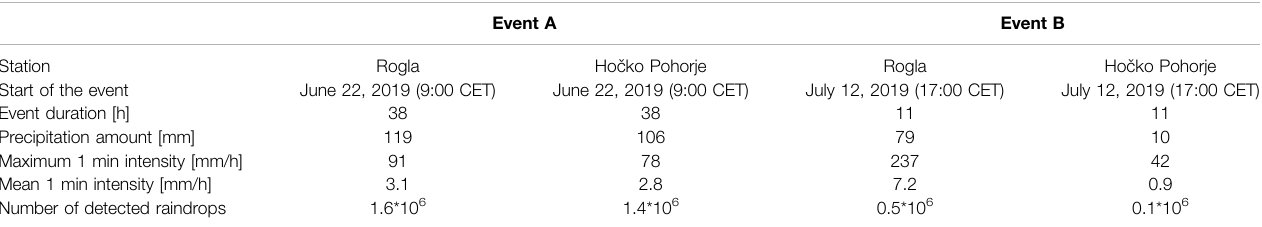
TABLE 2 | Main characteristics of the selected two events at Rogla and Ho č ko Pohorje